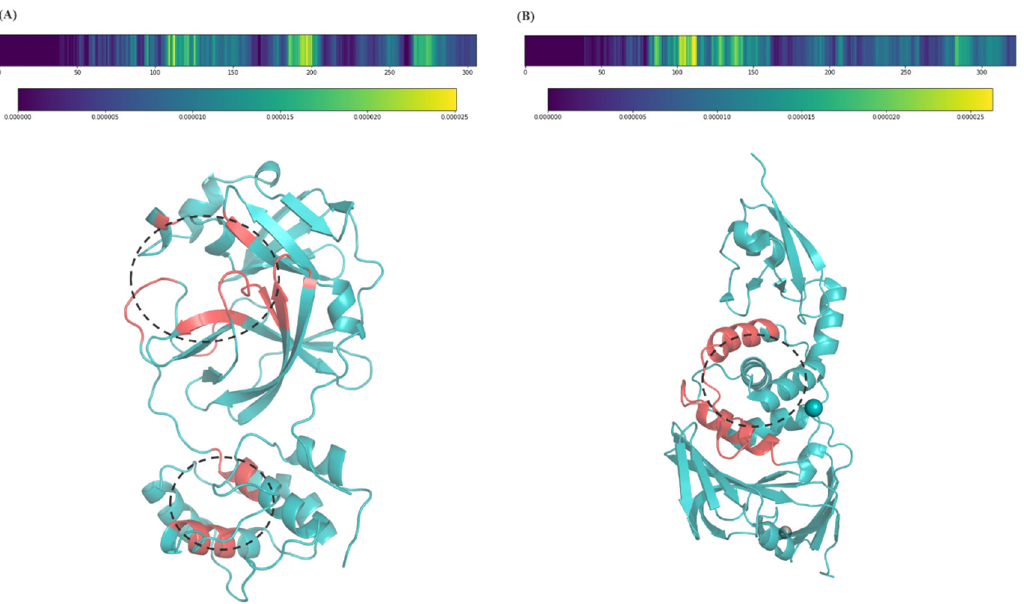
Figure 4. The predicted binding sites. ( A ) 3CLpro (PDB ID: 6lu7); ( B ) PLpro (PDB ID: 6wx4). The abscissa axis is the length of protein sequences. Red indicates the predicted important sites and black dotted circles indicate possible pockets.